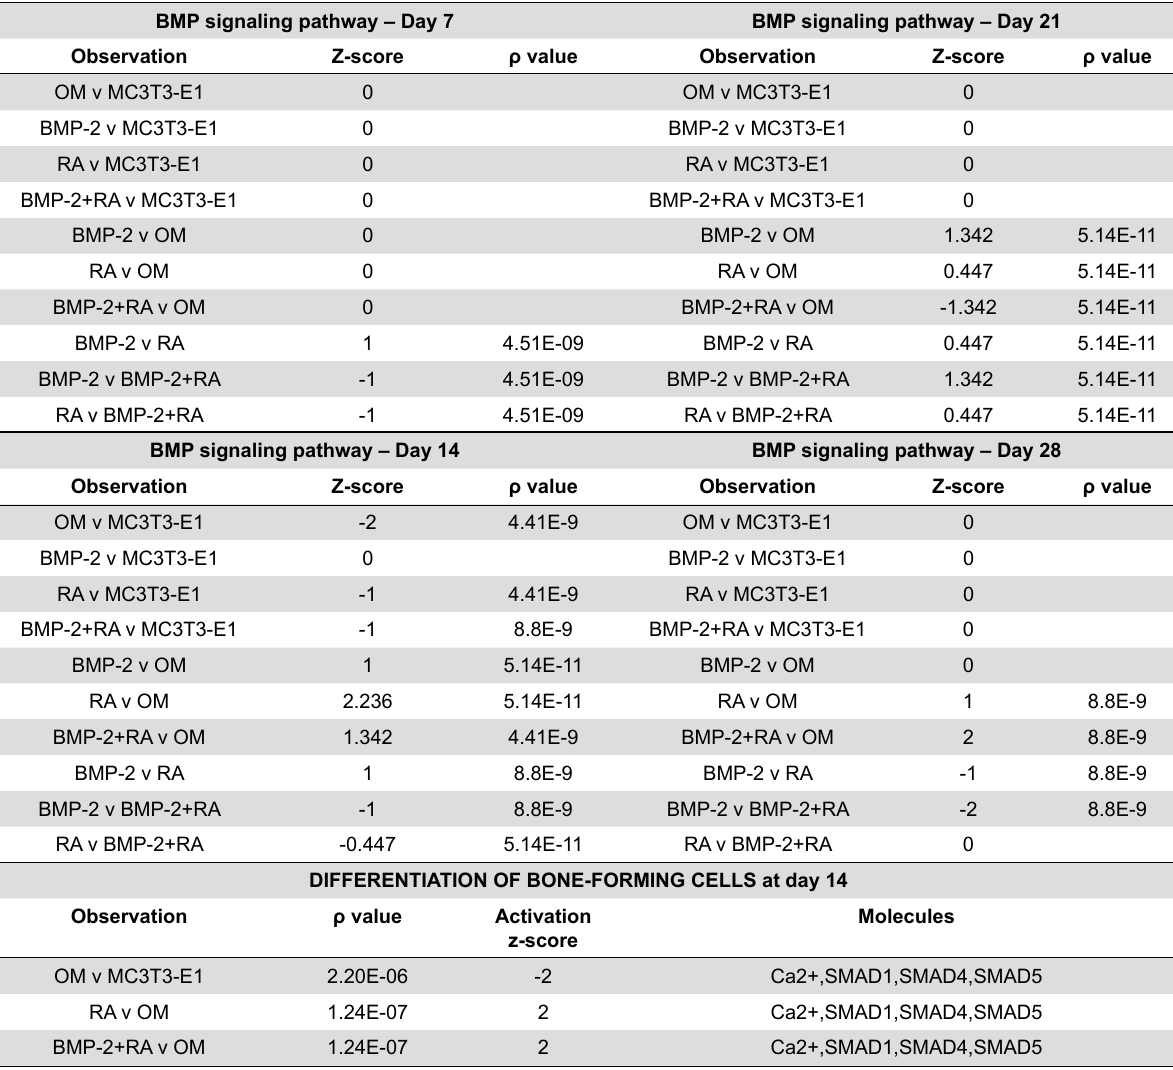
Table 1- Relation between the different cell treatments and the BMP signaling pathway indicated by IPA ® software at days 7, 14, 21, and 28. ASCs were treated according to the groups: OM (osteogenic medium); BMP-2 (OM and BMP-2); RA (OM and retinoic acid, RA); BMP-2+RA (OM, BMP-2, and RA). MC3T3-E1 was used as positive control. r <0.05 represents statistically significant difference. Positive z-score indicates up-regulation (highlighted in orange) and negative z-score implies down-regulation (highlighted in blue) of the signaling pathway evidenced by the IPA ® software